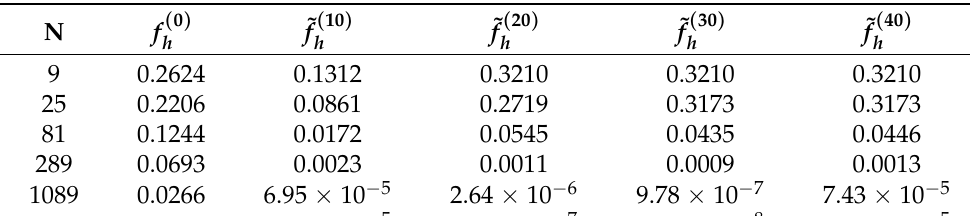
( 0 ) with p = 1. Data sites Ξ H . h